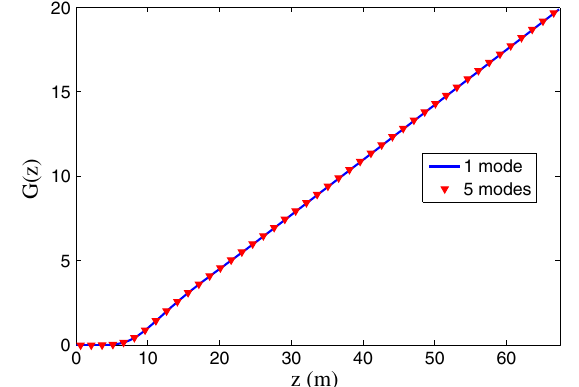
(cid:2) for an FEL driven 0